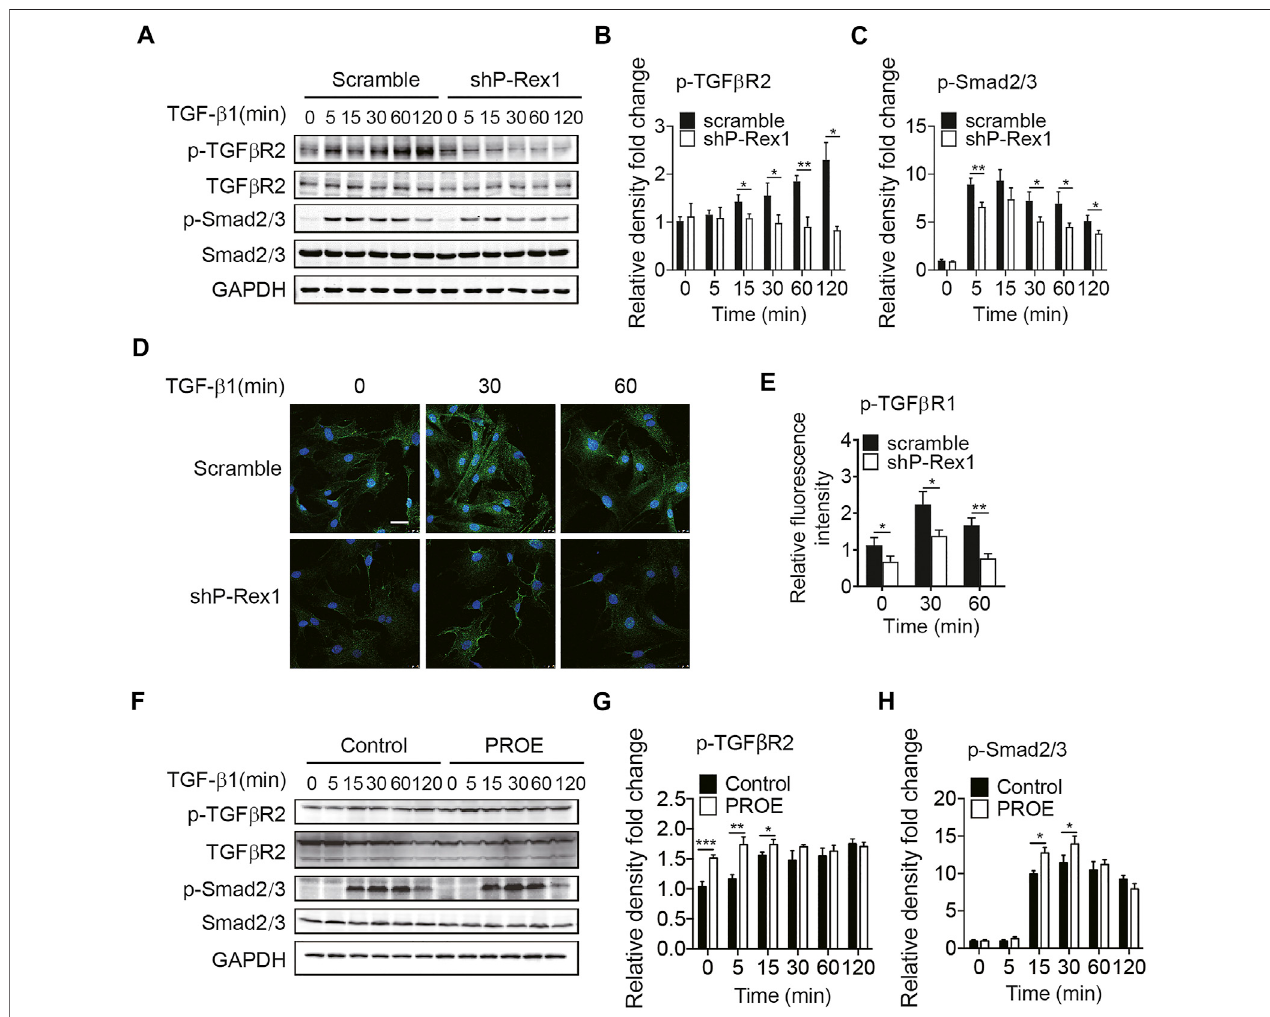
FIGURE 3 | P-Rex1 is downstream mediator of TGF- β 1 signaling in fi broblasts. (A – C) Levels of phosphorylation of TGF β R2 and downstream effector Smad2/3 after TGF- β 1 (10 ng/ml) stimulation for the indicated time in P-Rex1 knockdown (shP-Rex1) and scrambled control fi broblasts. (D , E) Immuno fl uorescence of TGF β R1 phosphorylation after TGF- β 1 (10 ng/ml) treated for the indicated time in different fi broblasts, and signal was quanti fi ed. Scale bars (cid:2) 10 μ m. (F – H) Levels of phosphorylation of TGF β R2 and Smad2/3 after TGF- β 1 (10 ng/ml) stimulation for the indicated time in P-Rex1 overexpression (PROE) and control fi broblasts. Quantitative data shown are mean ± SEM from three independent experiments (* p < 0.05, ** p < 0.01, and *** p <